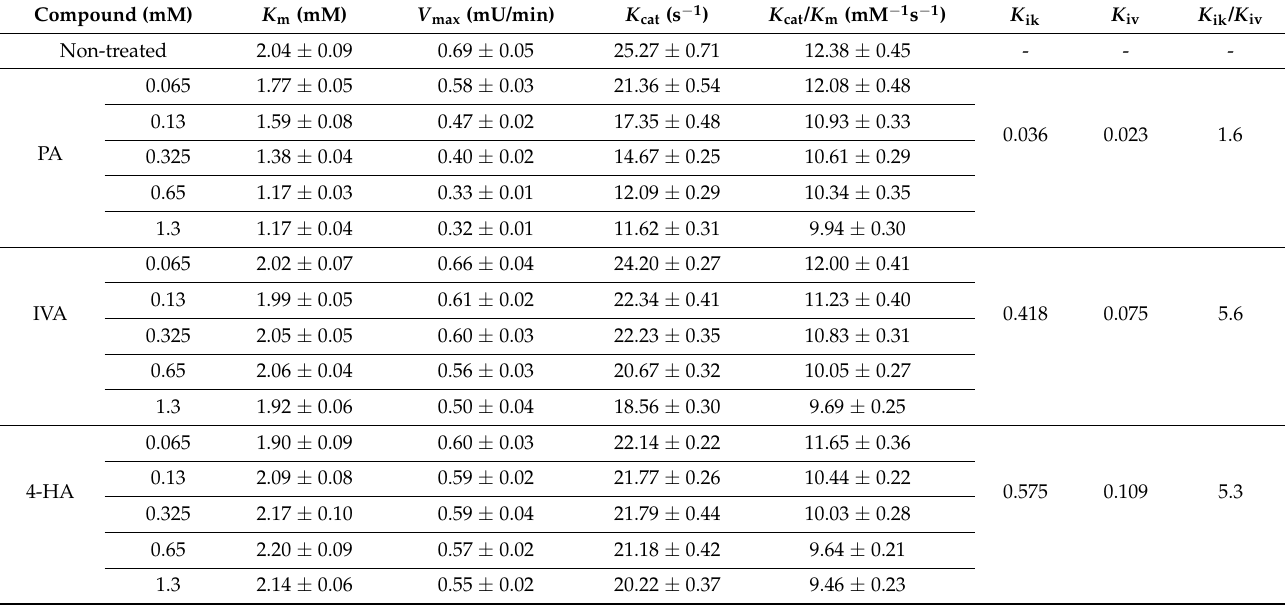
Table 2. Effect of PA, IVA, and 4-HA on kinetic parameters of